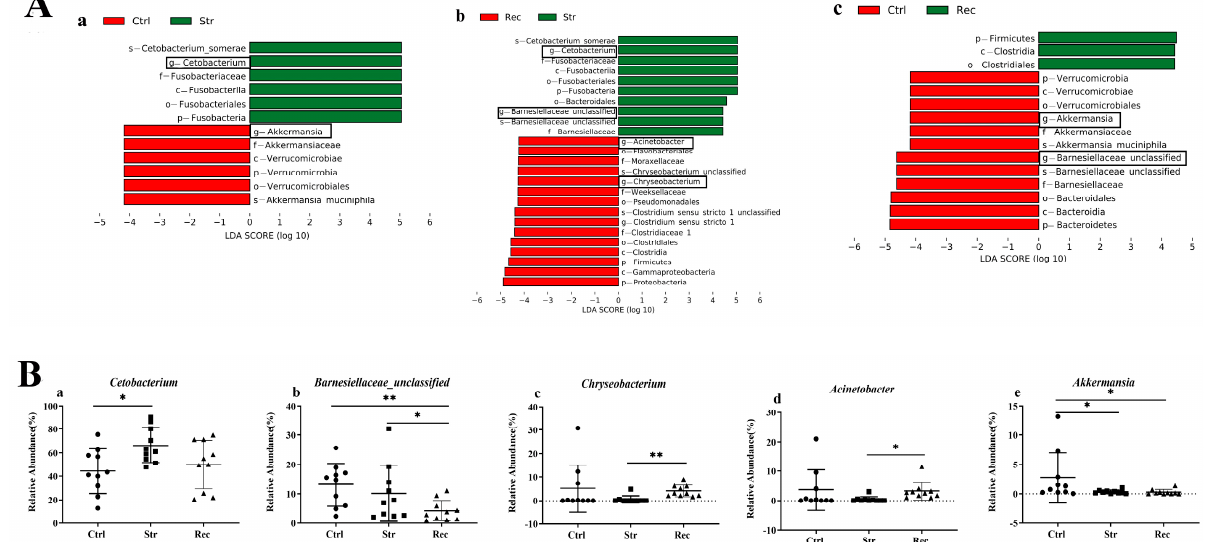
Str; ( c ): Ctrl vs Rec). ( B ) Abundance of dominate bacterial genera ( a – e ) in Ctrl, Str, and Rec (*, p < 0.05; **, p < 0.01). (*, p < 0.05; **, p < 0.01).